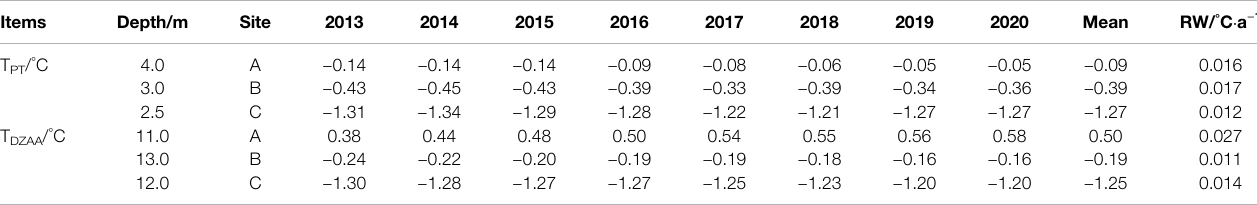
TABLE2| Annualmeangroundtemperaturesnearthepermafrosttable(siteA:4.0 m,siteB:3.0 m,siteC:2.5 m)andthedepthofzeroannualamplitude(siteA:11.0 m,site B: 13.0 m, site C:12 m) from 2013 to 2020. Items